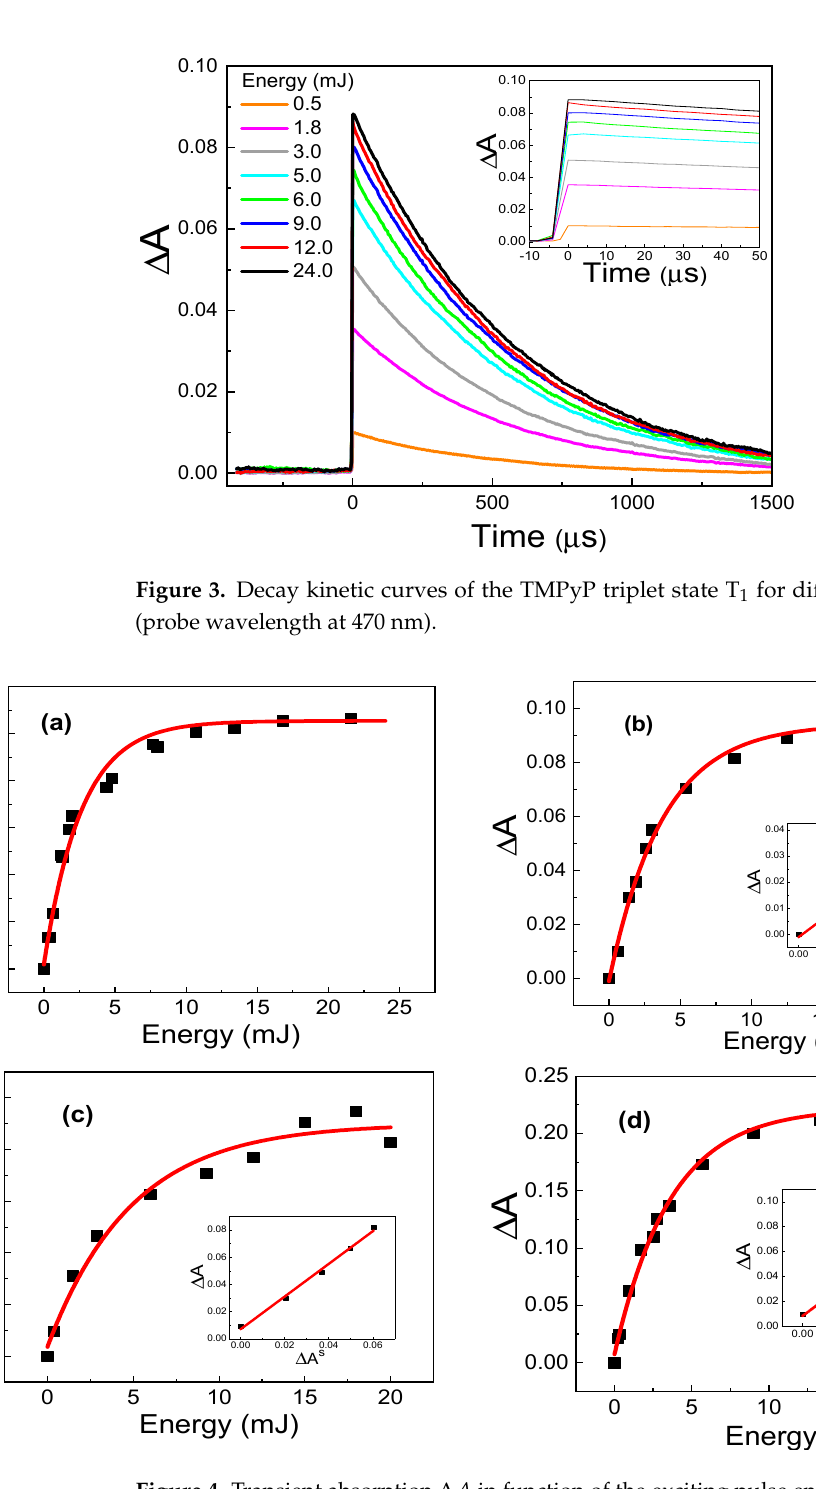
Figure 3. Decay kinetic curves of the TMPyP triplet state T 1 for di ff erent exciting pulse energies (probe wavelength at 470 nm).